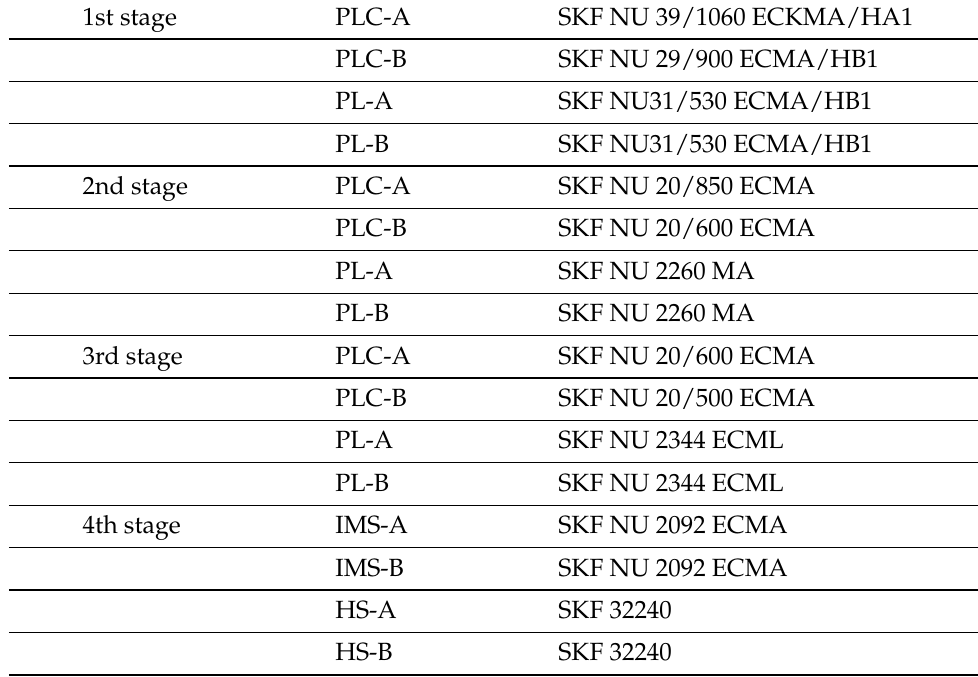
Table 7. Bearings overview (HS-3P1H).